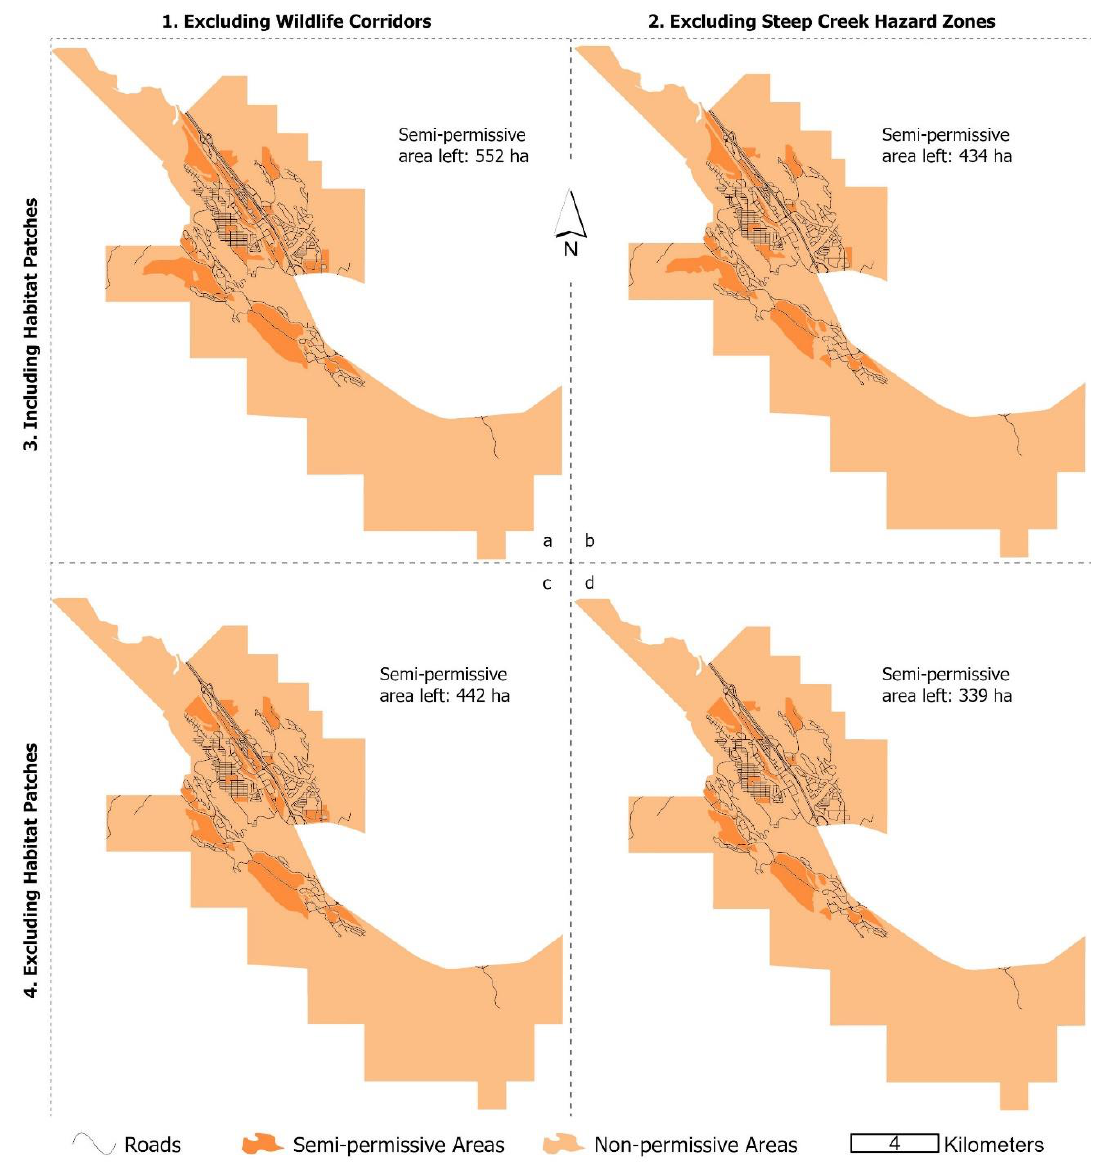
Figure 7. Four solar energy development scenarios are ( a ) excluding wildlife corridors; ( b ) excluding wildlife corridors and steep creek hazards zones; ( c ) excluding wildlife corridors and habitat patches; and ( d ) excluding habitat patches and steep creek hazard zones.